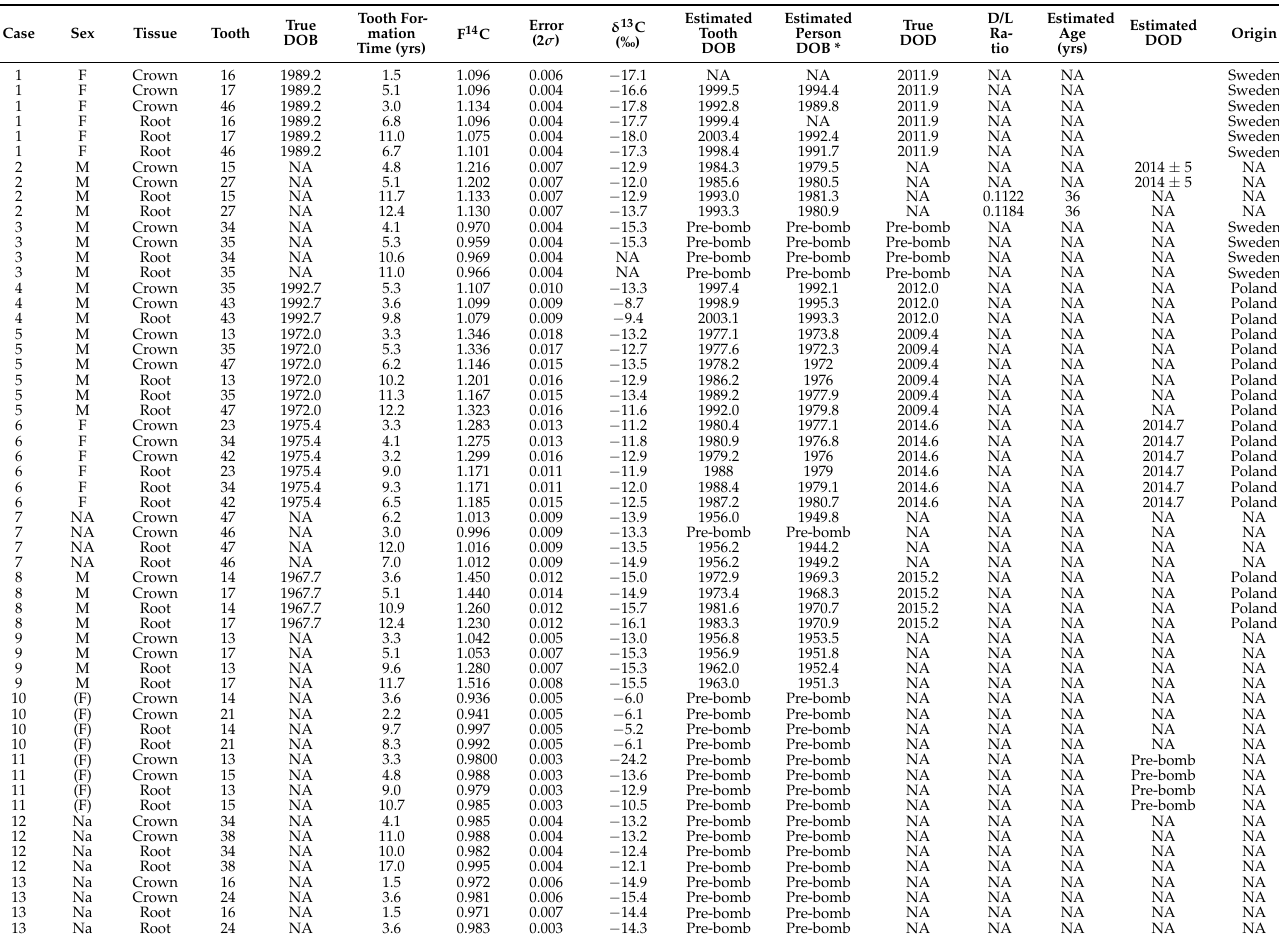
Table 2. AMS F 14 C results for the tooth crowns and roots analyzed, and the estimated year of birth of the individuals. Case Sex Tissue